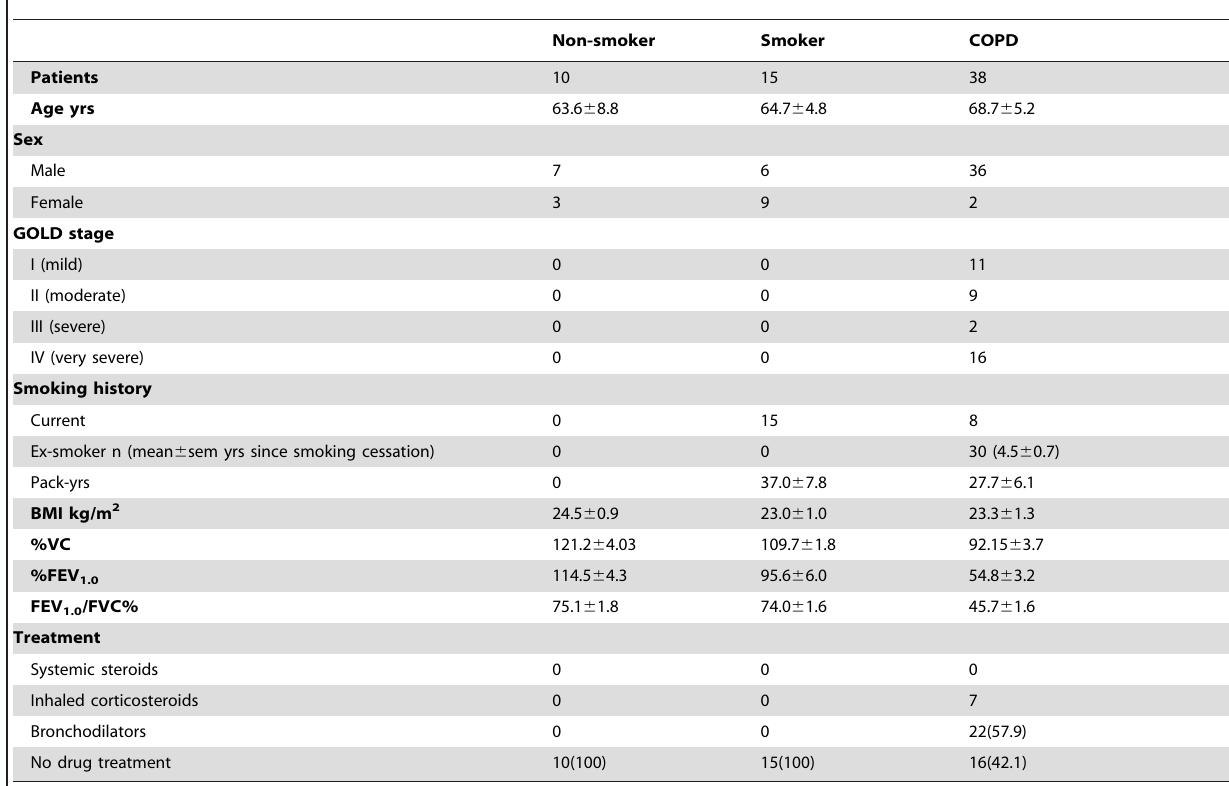
Table 1. Clinical characteristics of non-smokers, smokers and chronic obstructive pulmonary disease (COPD) patients examined by immunohistochemical analysis.